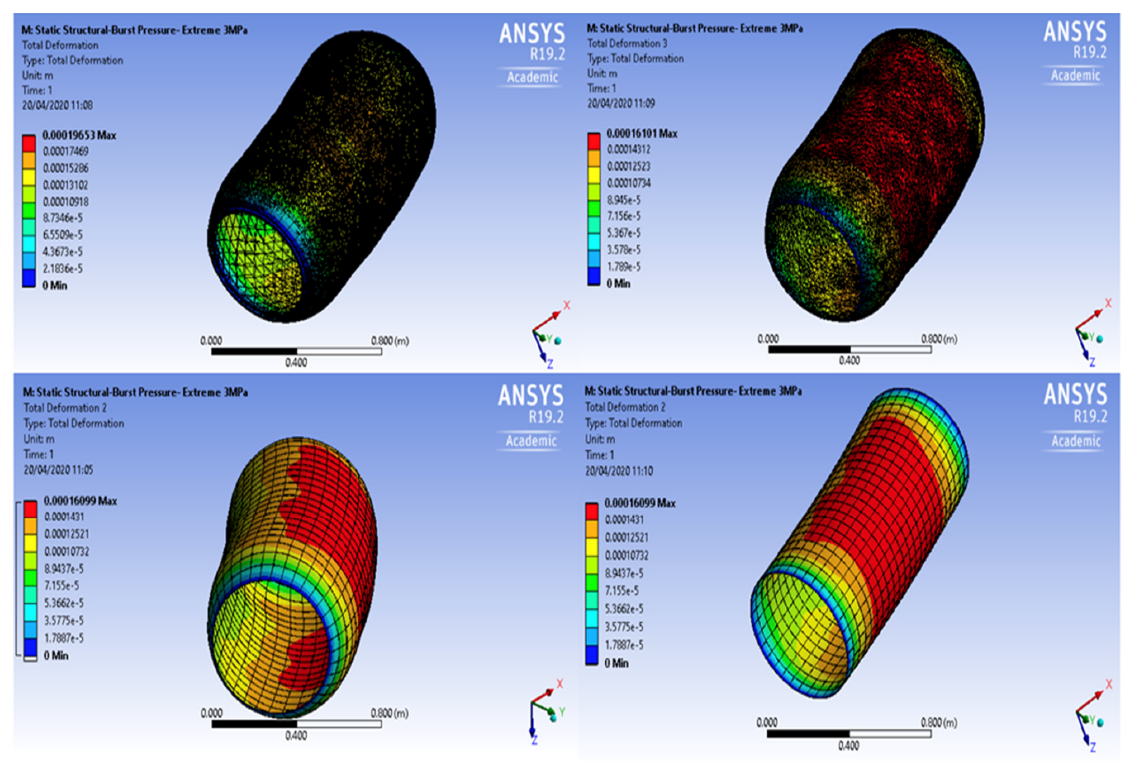
Figure 17. Burst loading of different layers under operational conditions for total deformation without wrinkling, for four different layers of the marine hose.